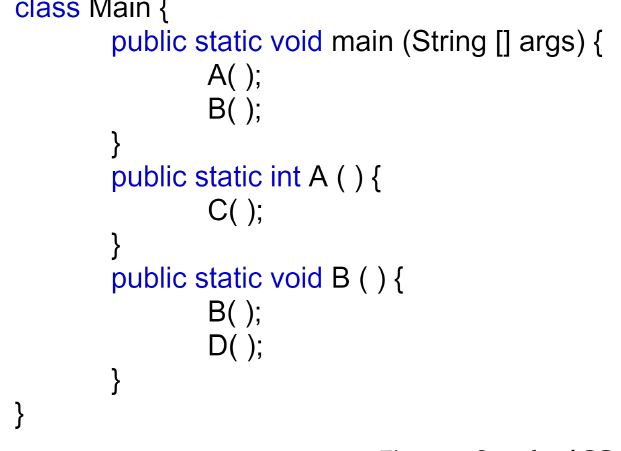
Figure 3. Sample of